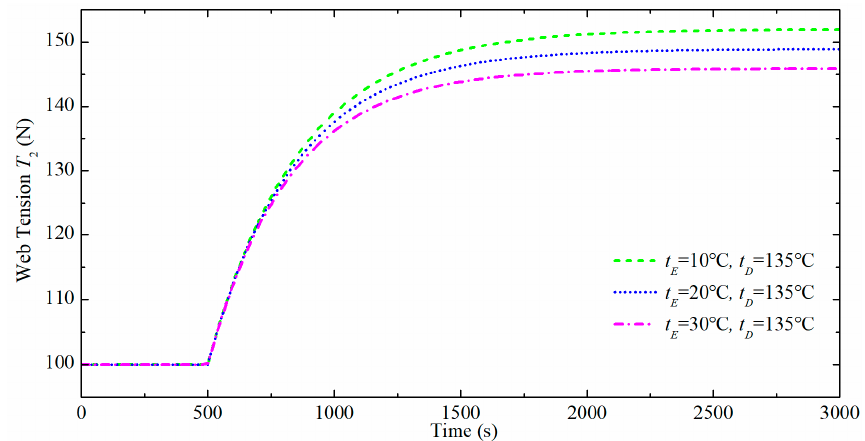
( ) T t as ( ) v t has step changes at different room temperatures 2 2